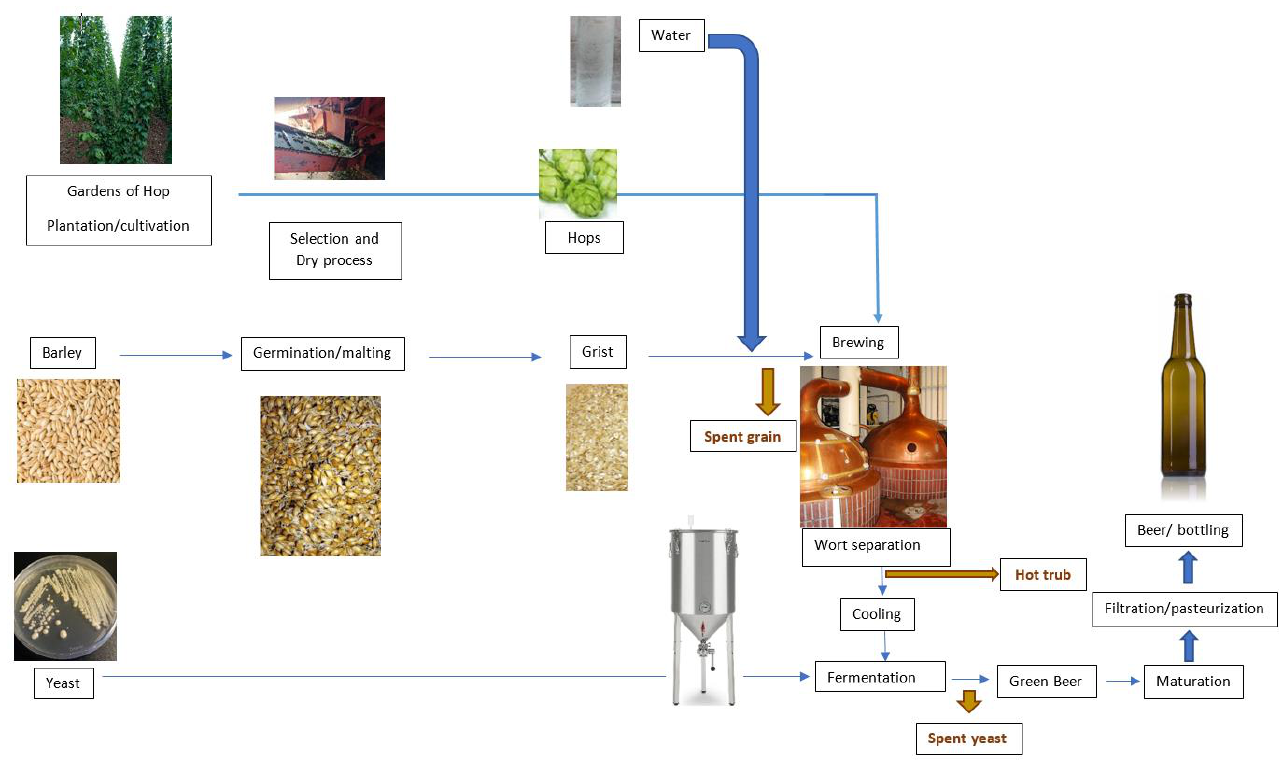
Figure 1. By - products generated in brewing process. Adapted from [14,16] . Figure 1. By-products generated in brewing process. Adapted from